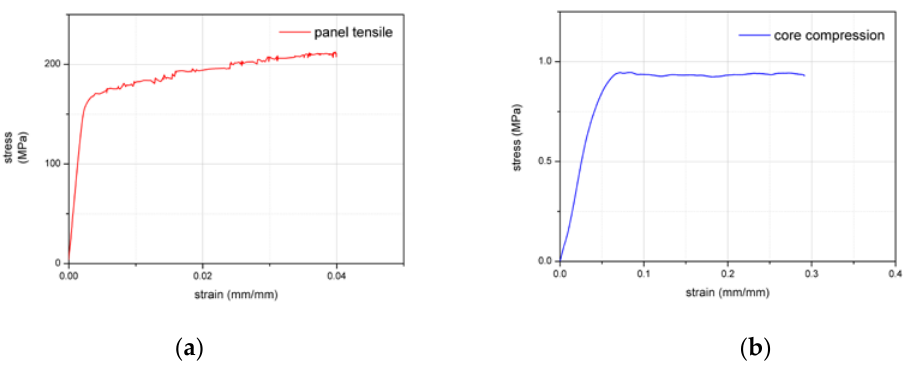
Figure 2. ( a ) Stress–strain curve of aluminum alloy panel and ( b ) stress–strain curve of foam core.